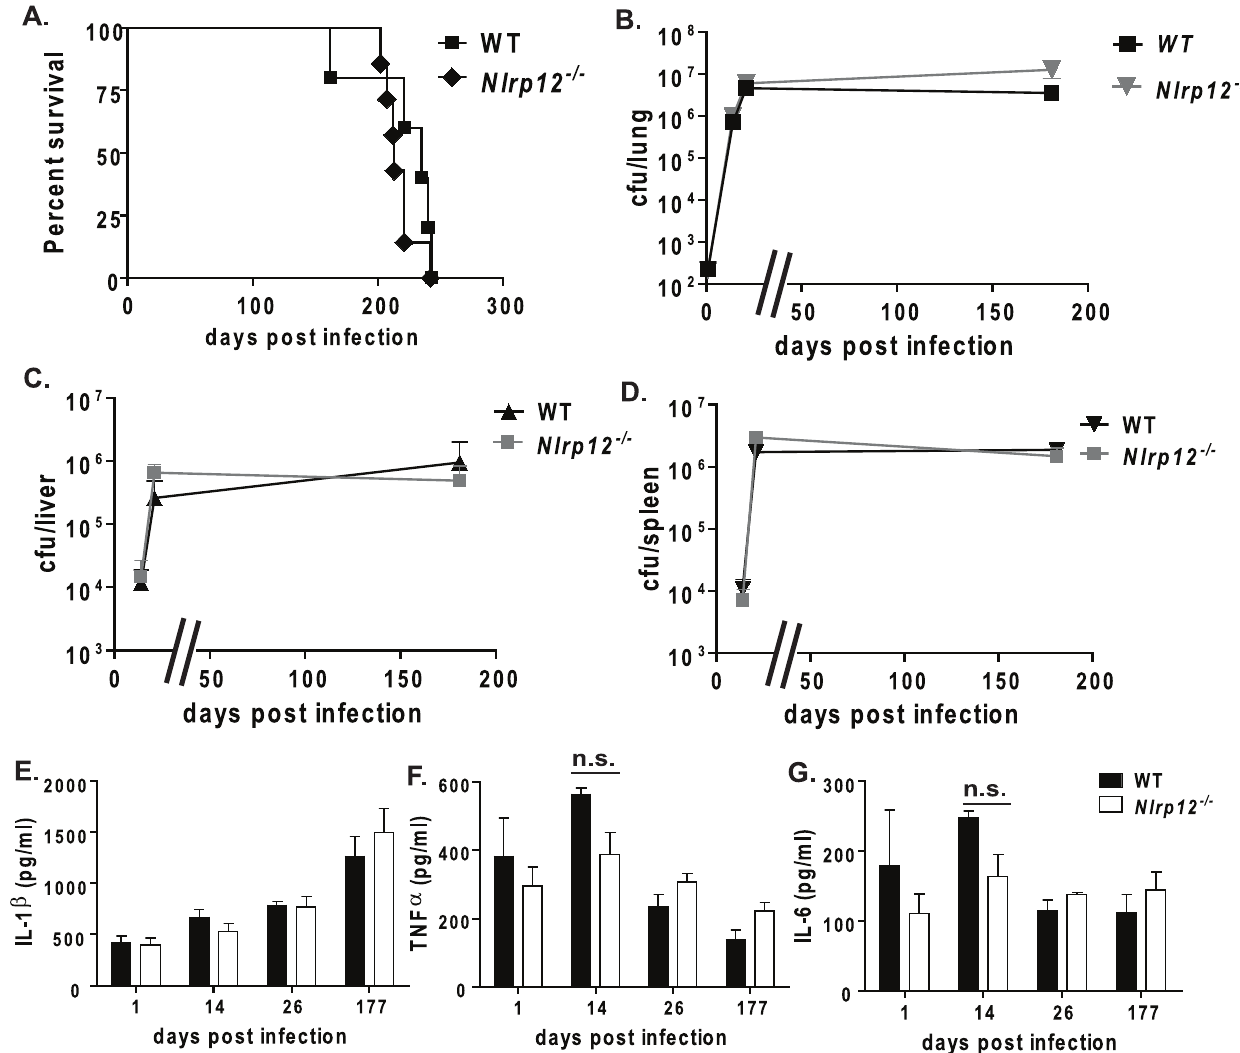
showed that Nlrp12 2 / 2 and wild-type lungs had similar amounts of cytokines at one day post-infection and during chronic Mtb infection. At 14 days post-infection, Nlrp12 2 / 2 lungs had reduced cytokines compared to wild-type lungs that neared significance (p=0.056 and p=0.06, respectively). Bacteria burden and cytokine measurements at each time point were taken from 3 mice per genotype per time point. Nlrp12 2 / 2 , n=19; Wild type, n=17; Experiments were repeated 2 separate times with a minimum of 12 Mtb infected Nlrp12 2 / 2 and wild type mice in each group. At least 3